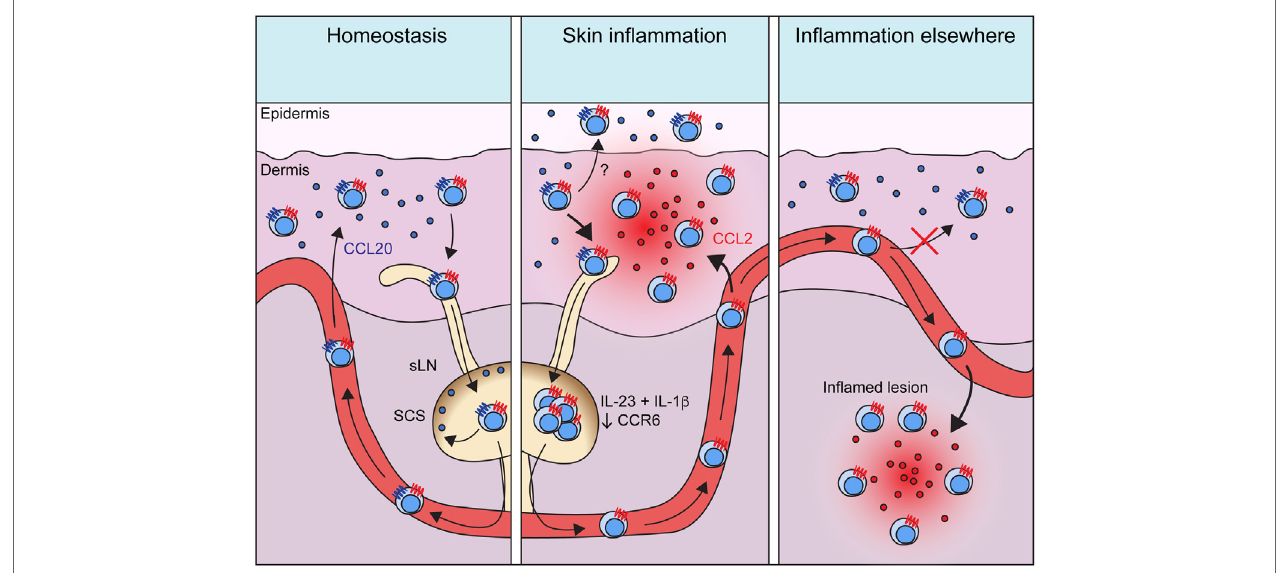
FigURe 2 | Migratory dynamics of γδ T17 cells. Under homeostasis, γδ T17 cells largely reside in barrier tissues such as the dermis, but also drain slowly into sLNs and are detectable in the blood. Circulating γδ T17 cells return to the skin using CCR6 which directs them toward CCL20 expressed in the dermis. CCR6 also positions γδ T17 cells in the sLN SCS to scan for invading microbes. During skin inflammation, γδ T17 cell trafficking from the dermis to sLNs is increased. γδ T17 cells undergo proliferation driven by IL-23 and IL-1 β in sLNs, where they lose CCR6 expression. Activated and expanded γδ T17 cells then home via the blood to inflamed skin using CCR2, which senses ligands such as CCL2 induced during inflammation. CCR6 probably recruits γδ T17 cells into the epidermis during skin inflammation, but how its expression is maintained in this scenario is unknown. During inflammation in other peripheral organs, γδ T17 cells similarly proliferate in LNs via IL-23 and IL-1 β and become CCR6 − . They then traffic via circulation to infiltrate the inflamed site via CCR2. Loss of CCR6 expression is required for optimal γδ T17 cell recruitment to such inflammatory sites, as it prevents activated γδ T17 cells from instead homing to unaffected dermis. Abbreviations: sLN, skin-draining lymph node; SCS, subcapsular